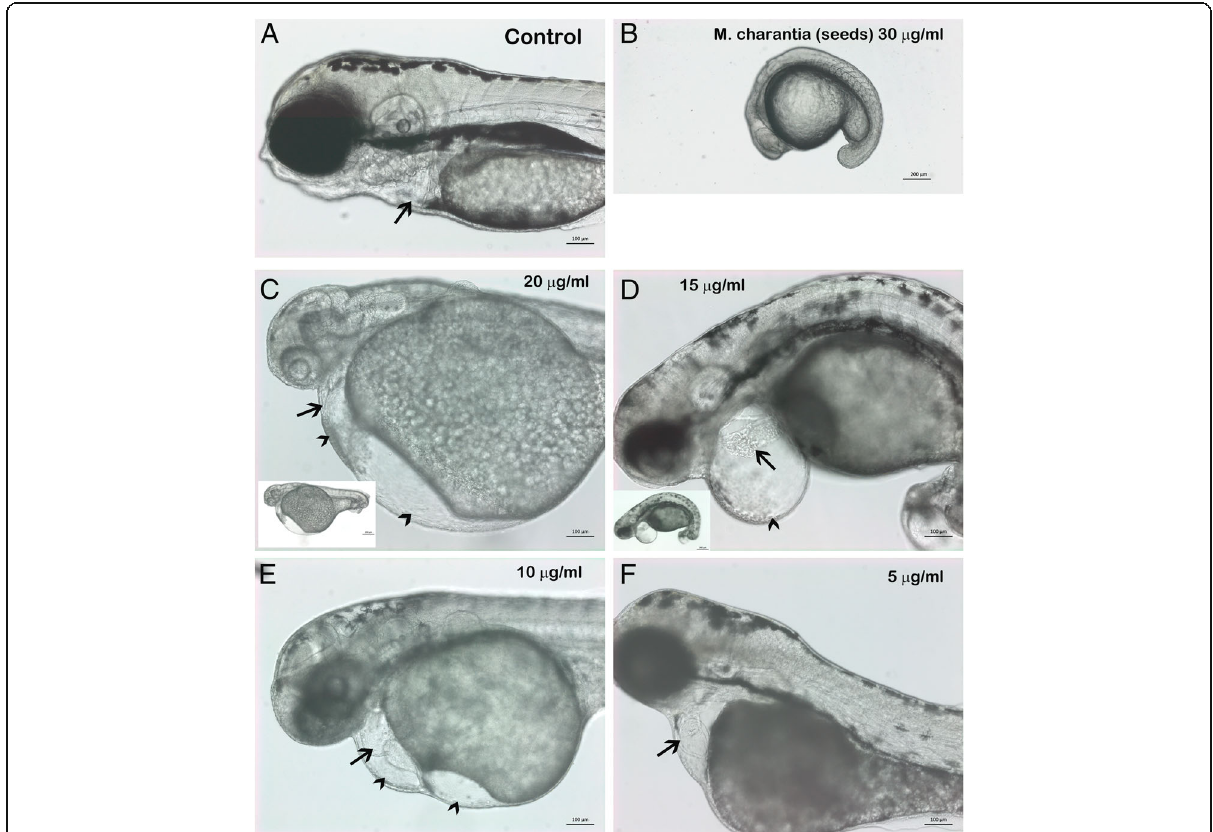
Fig. 1 Seed extract of Momordica charantia induced multiple teratological defects in developing zebrafish embryos. Representative photomicrograph of live zebrafish embryos at 3dpf control ( a ) and treated with various concentration of seeds extract of M. charantia (B-F). The highest concentration in which treated embryos could survive was 50 μ g/ml and the representative image of treated embryos are presented in b . The embryos treated with 50 μ g/ml of seeds extracts were severely developmentally delayed as compared to mock treated embryos as shown in a . The control embryos developed to 72hpf, after two days but treated embryos were at 15 somite stage after two days of exposure . c The zebrafish embryos which were treated with 25 μ g/ml of the seeds extract exhibited multiple teratogenic effect. The treated embryos were developmentally delayed as compared to control, had small head, enlarged yolk (yolk), severe cardiac hypertrophy (arrow), enlarged cardiac cavity (arrow head) absence of tail extension (shown in small inset) absence of circulation (shown in Additional file 1 as supplementary data d). The zebrafish embryos treated with 15 μ g/ml of seeds extract of M. charantia also had mild level of developmental delay, enlarged cardiac cavity (arrow head). The heart was severely affected as both atrium and ventricle were fused representing as string (black arrow). The treated embryos had curved trunk as shown in small at lower magnification. e. the zebrafish embryos treated with 10 μ g/ml of the seeds extract had mild level of developmental delay but the treated embryos ad severe cardiac hypertrophy (arrow) and also enlarged cardiac cavity (arrow head). f ). zebrafish embryos treated with 5 μ g/ml of the seeds extract did not show development delay however, the cardiac hypertrophy (arrow) was evident in treated embryos. All embryos anterior to the